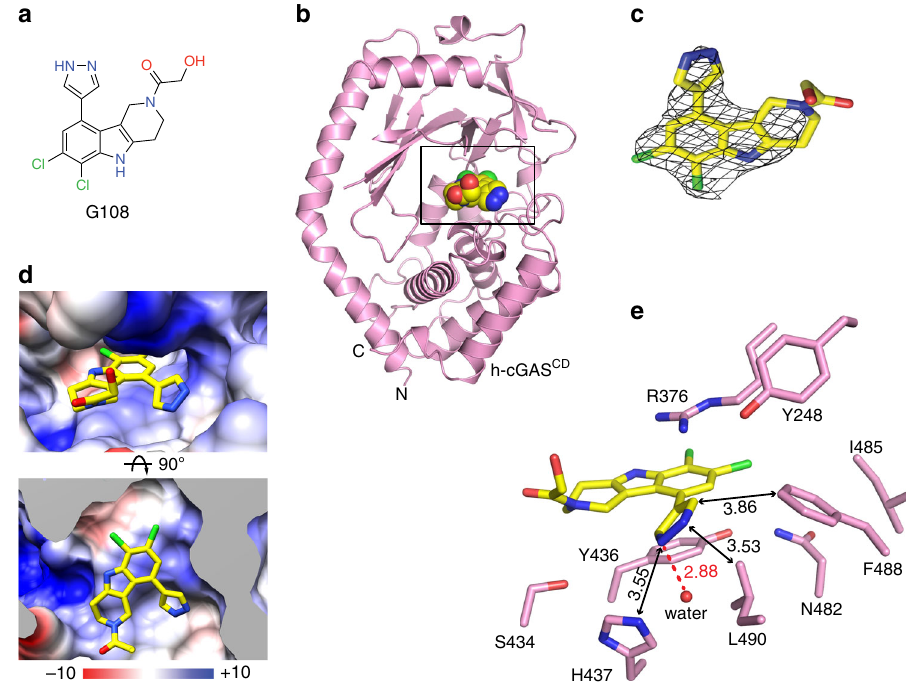
Fig. 4 Structure of G108 bound to apo h-cGAS CD . a Chemical formula of G108 . b Crystal structure of G108 bound to apo h-cGAS CD . The bound G108 is shown in a space- fi lling representation, and the binding pocket is boxed. c 2Fo – Fc electron density map of bound G108 contoured at 1.2 σ level. The electron density is poorly de fi ned for the hydroxyl-ethanone side chain attached to the non-planar six-membered ring. d Two views of G108 positioned in its binding pocket within h-cGAS CD with the protein shown in an electrostatic surface representation. Electrostatic surface potentials were calculated with Coulombic Surface tool in Chimera with thresholds ±10 kcal mol − 1 e − 1 . e Intermolecular contacts and key distances between G108 and amino acids lining the binding pocket of h-cGAS CD . Distances are in angstrom. Red dashed line indicates hydrogen